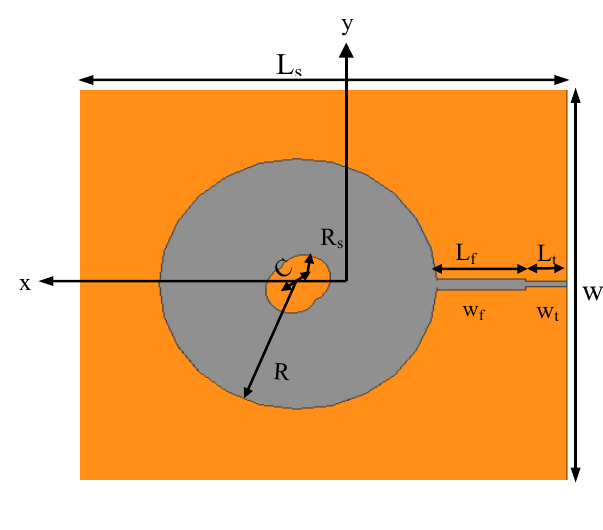
Fig.1. The configuration of the CP microstrip on-chip patch antenna with L h =22 µ m, R=0.6825 mm, R d L =0.2 mm, w t